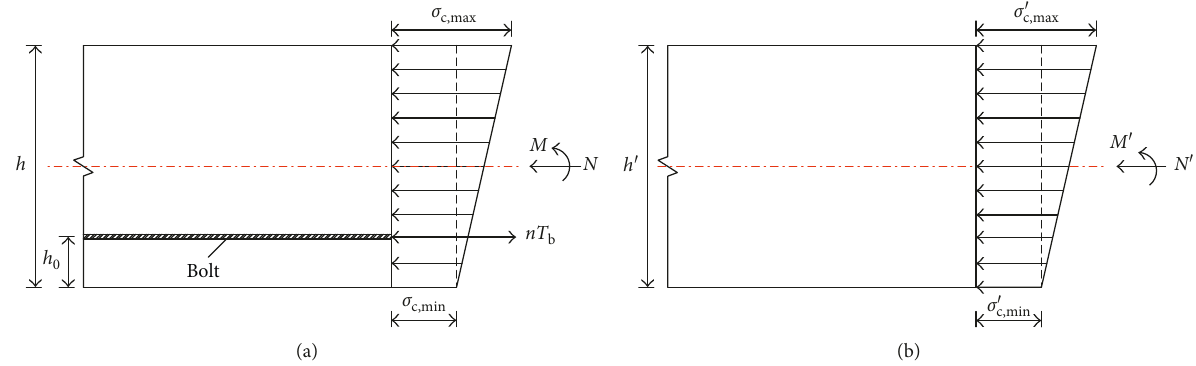
Figure 3: Mechanical characteristic of the joint section under positive bending moment and small eccentricity pressing condition. (a) Original joint section. (b) Equivalent joint